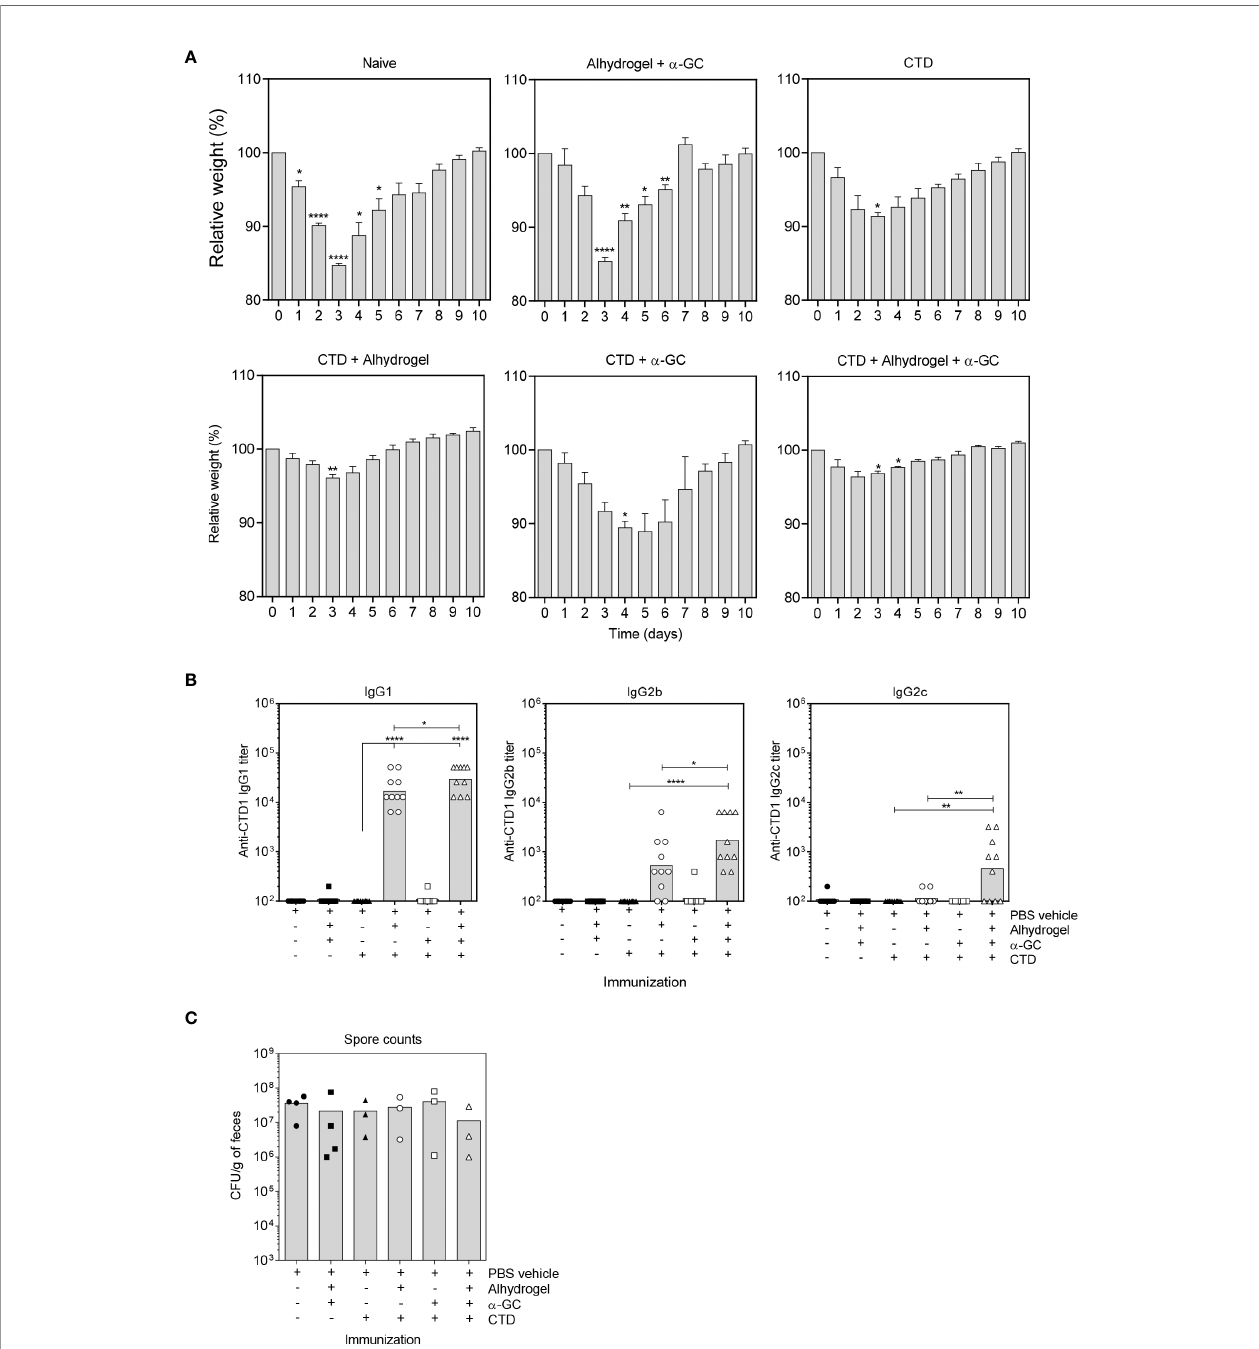
FIGURE 1 | A single dose of Alum-adsorbed CTD affords suf fi cient protection against C. dif fi cile but inclusion of a -GC broadens the humoral immune response to TcdB. (A) B6 mice were immunized s.c. as indicated with a single dose of each vaccine. After 28 days, mice were bled and treated with Cefoperazone for 5 days. After antibiotic withdrawal and provision of regular drinking water for 2 days, mice were orally gavaged with 5 x 10 4 live C. dif fi cile spores. Weights were then monitored daily. Graphs show mean ± SEM percentages of pre-infection weights for 5 mice per group. A Two-way repeated measures ANOVA with Dunnett ’ s multiple comparisons test was used to detect statistically signi fi cant differences in weight. Data are representative of two similar experiments. (B) Anti- CTD IgG1 (left), IgG2b (middle), and IgG2c (right) were detected by ELISA. Endpoint titers are shown, and each data point represents an individual mouse. Data from two pooled experiments is shown. Statistical signi fi cance was detected by ANOVA with Dunnett ’ s multiple comparison test. (*P < 0.05; **P < 0.01; ****P < 0.0001). (C) C. dif fi cile spore counts in day 3 fecal pellets were determined as described in materials and methods. Pellets could not be collected from every mouse which was attributed to